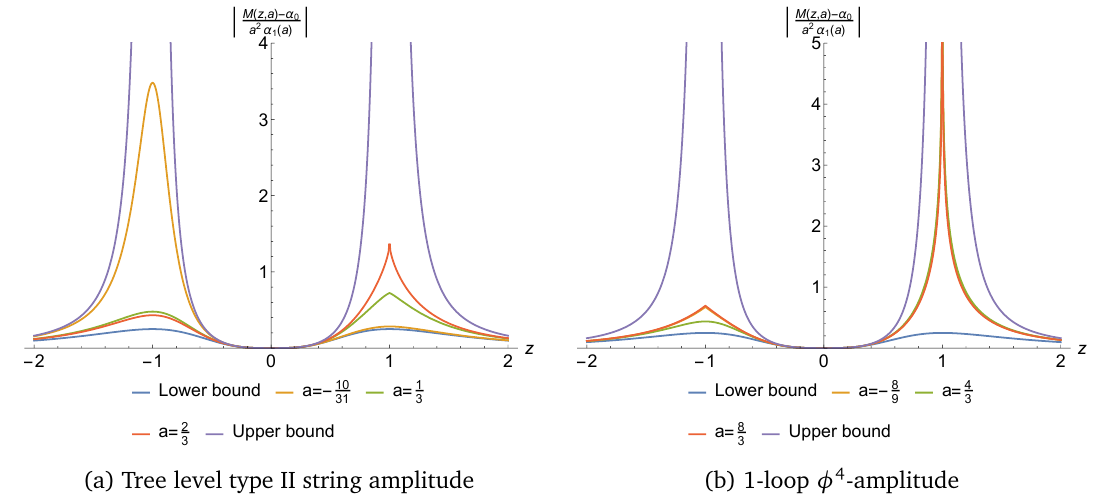
Figure 5: Bounds on amplitude, as in theorem (6.1), are satisfied by Tree level type II string amplitude and 1-loop φ 4 -amplitude.